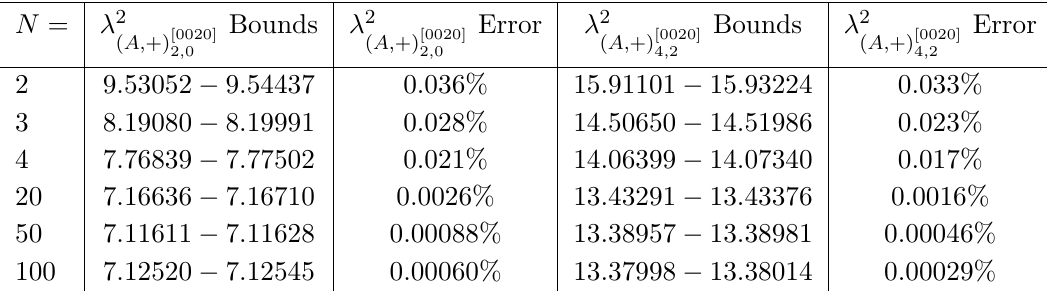
Table 8 . Upper and lower bounds on OPE coe(cid:14)cients squared for semishort ( A; +) [0020] using the single correlator h 2222 i with (cid:3) = 43 and the short OPE coe(cid:14)cients (cid:12)xed to their values for ABJM int using the 1d theory in section 3 for N = 2 ; 3 ; 4 ( N = 2 was already reported in [38]), N; 1 and the all orders in 1 =N results from [56] for N = 20 ; 50 ;